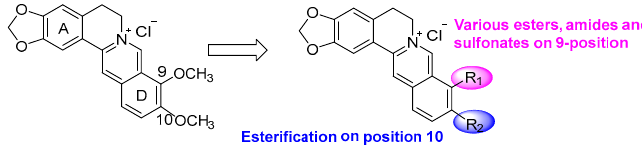
Figure 1. Chemical structures of berberine (BBR), and its structure modification strategy.